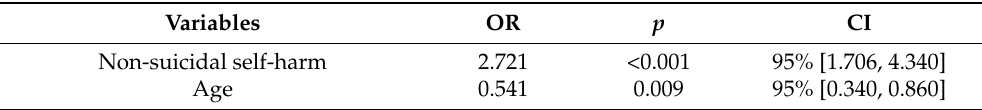
Table 5. Statistical significant model for binary logistic regression ( χ 2 (3, n = 533) = 34.843; p < 0.001; Nagelkerke R 2 =